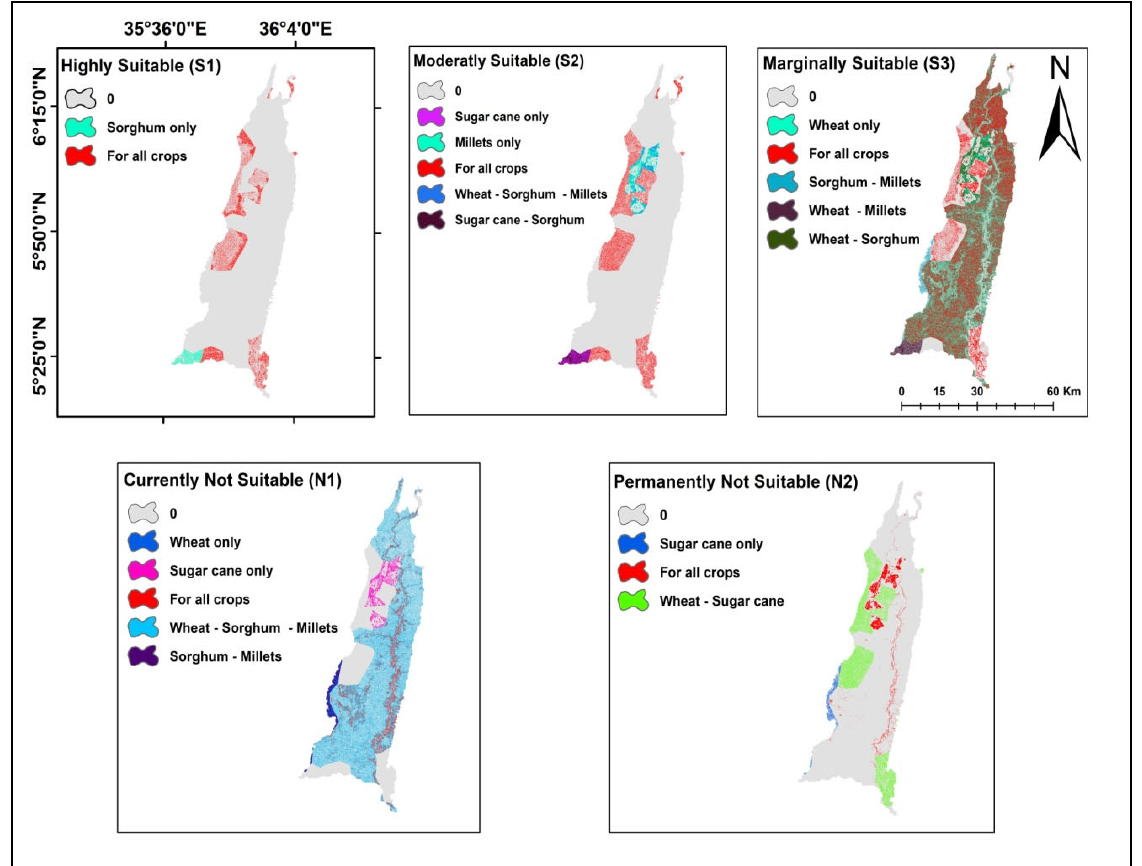
Figure 7. The land series codes corresponding to crop and suitability class.